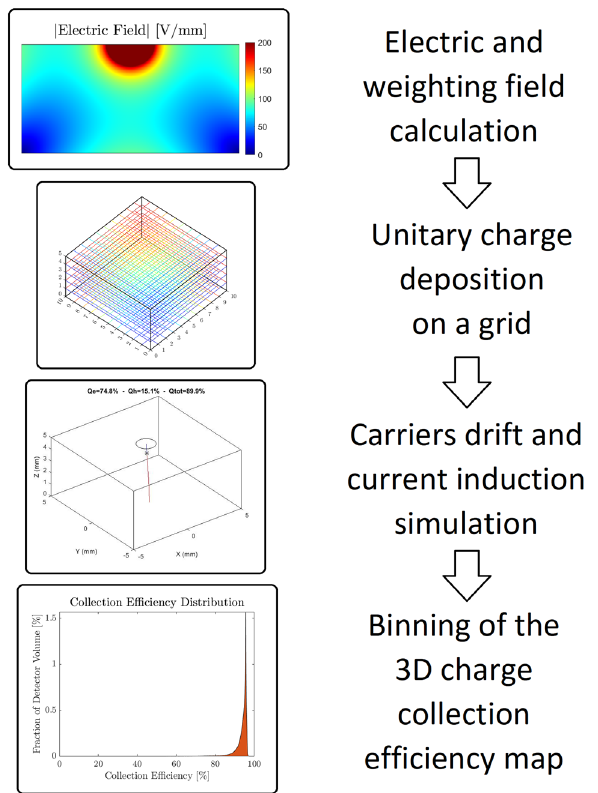
Figure 1. Schematization of the simulation process with a graphical representation of each of the four steps described in the